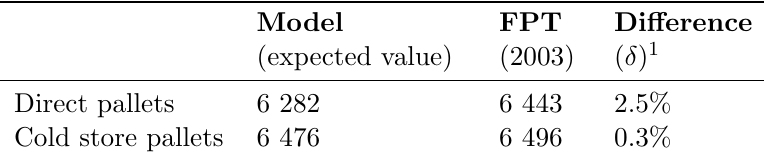
Table 2: Comparison of number of truck arrivals at FPT for validation.